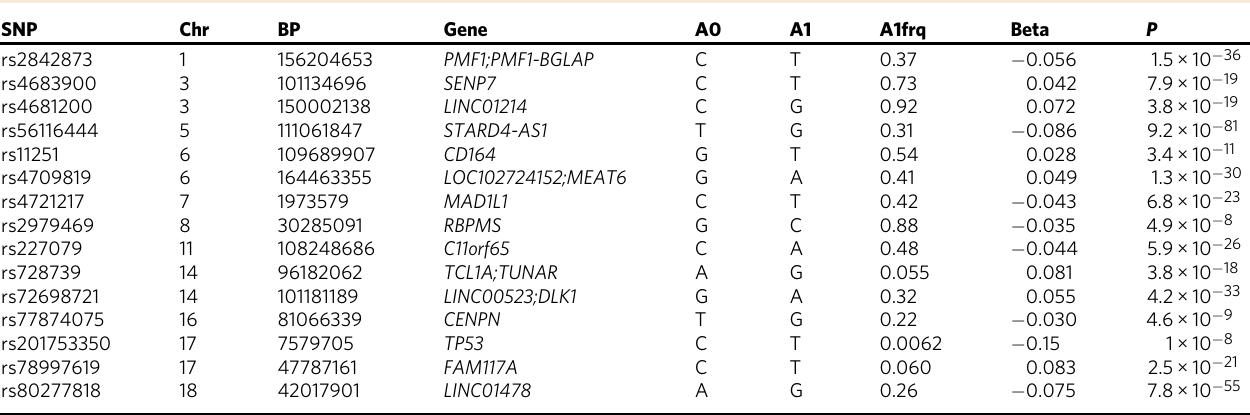
Table 2 Signi fi cant signals in the 15 known loci